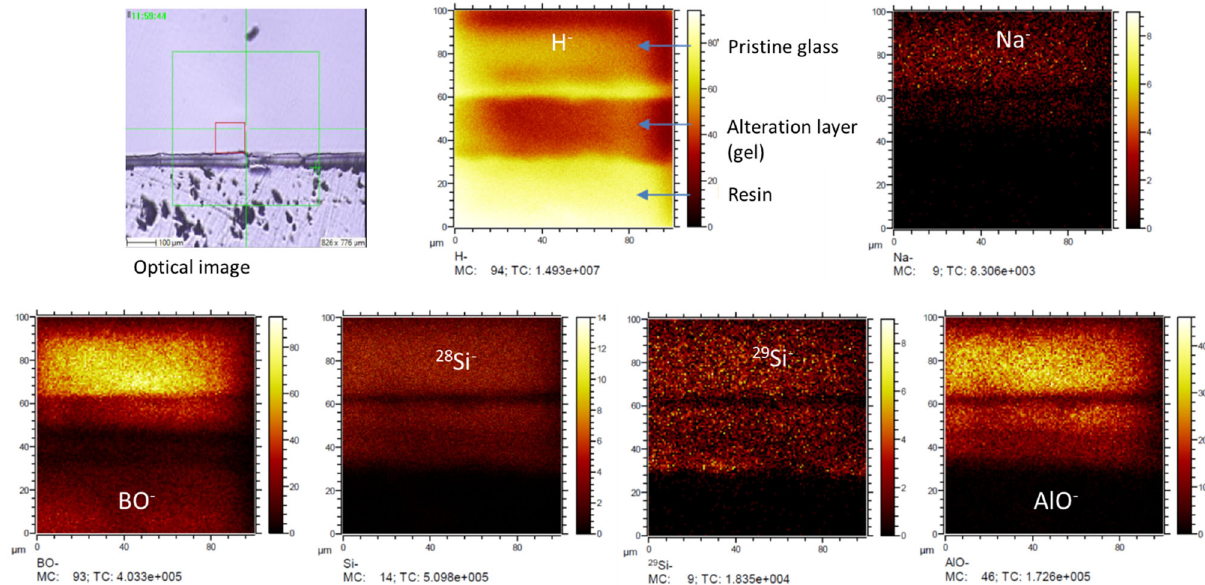
Fig. 8 ToF-SIMS elemental and isotopic mappings of sample E (non-irradiated glass altered for 83 days at pH 3 in silica saturation conditions). Note that the mappings are recorded within the green square shown on the optical image but do not correspond to the red square.